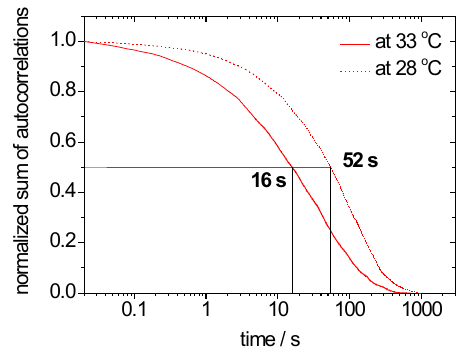
0.1 Figure 4. Sum of single molecule autocorrelation functions with indicated times at which autocorrelation drops to its half